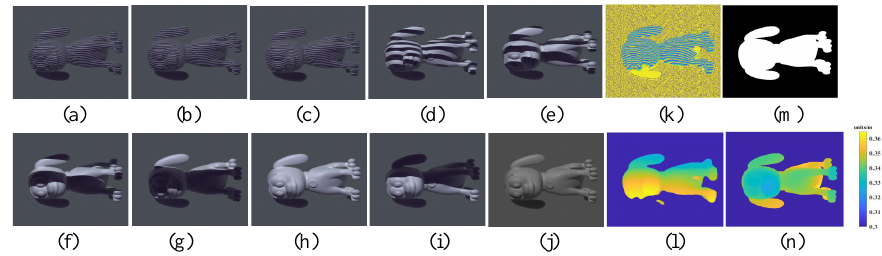
Figure 3. One sample in the dataset. ( a – c ) Three phase-shifting fringe patterns projected on an object; ( d – i ) Six gray code images projected on an object; ( j ) The corresponding texture image; ( k , l ) The corresponding wrapped phase map and unwrapped phase map; ( m ) The mask generated by a depth threshold; ( n ) The corresponding ground truth (the depth map directly exported from the virtual